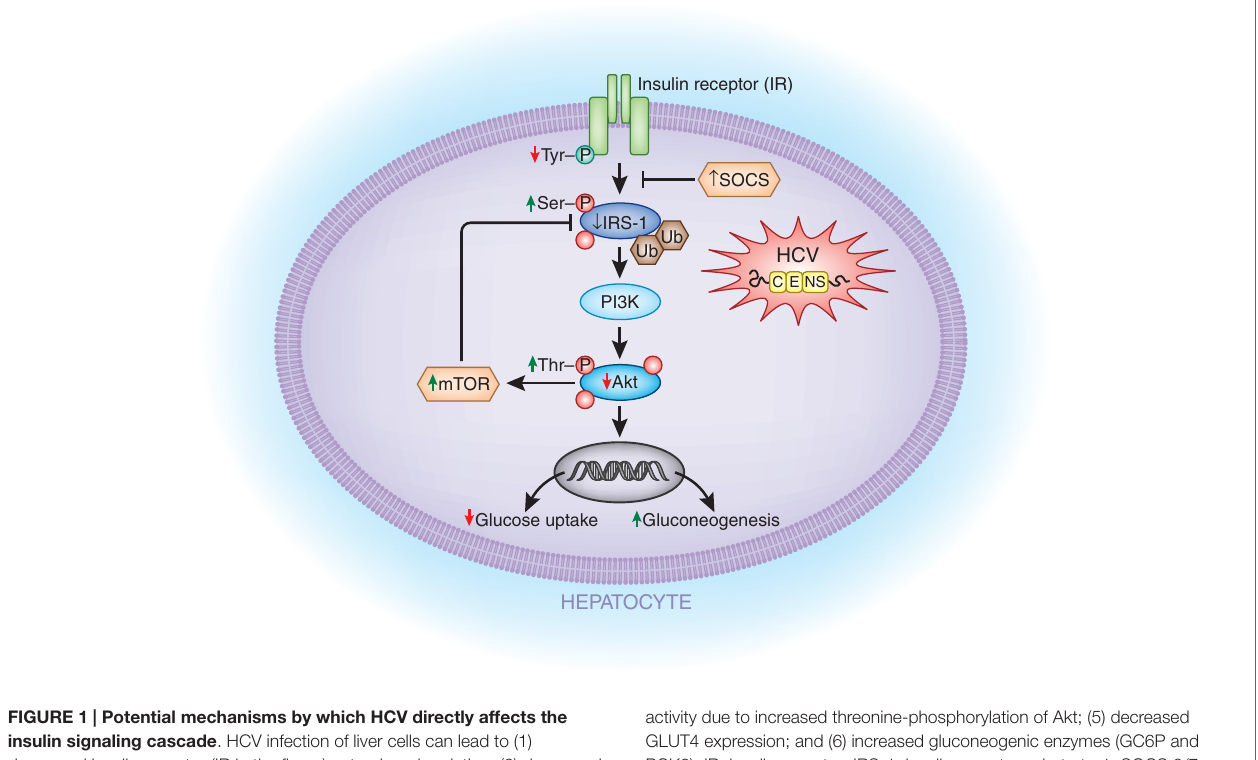
FiGURe 1 | Potential mechanisms by which HCv directly affects the insulin signaling cascade . HCV infection of liver cells can lead to (1) decreased insulin receptor (IR in the figure) auto phosphorylation; (2) decreased IRS-1 activation due to increased serine-phosphorylation of IRS-1; (3) decreased IRS-1 levels due to increased ubiquitin-mediated proteasomal degradation induced by SOCS 3/7 and mTOR upregulation; (4) reduced Akt